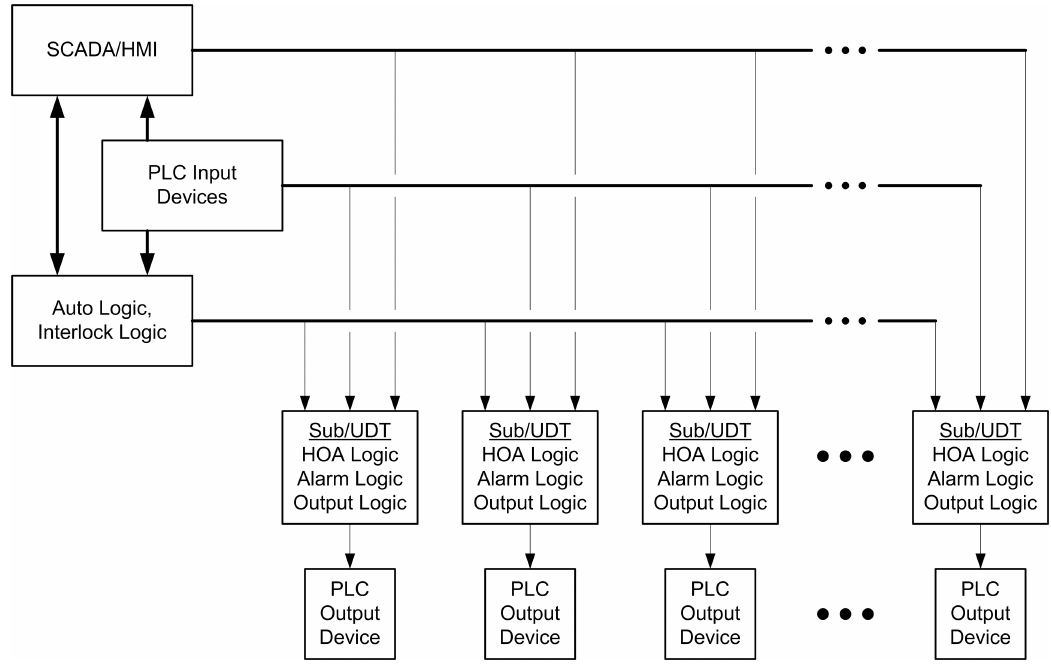
Figure 2. Framework used to implement the old architecture.